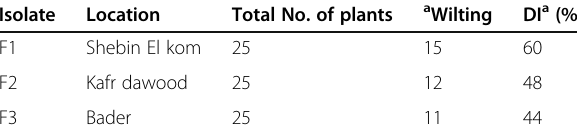
Table 1 Pathogenicity test for different isolates of F.